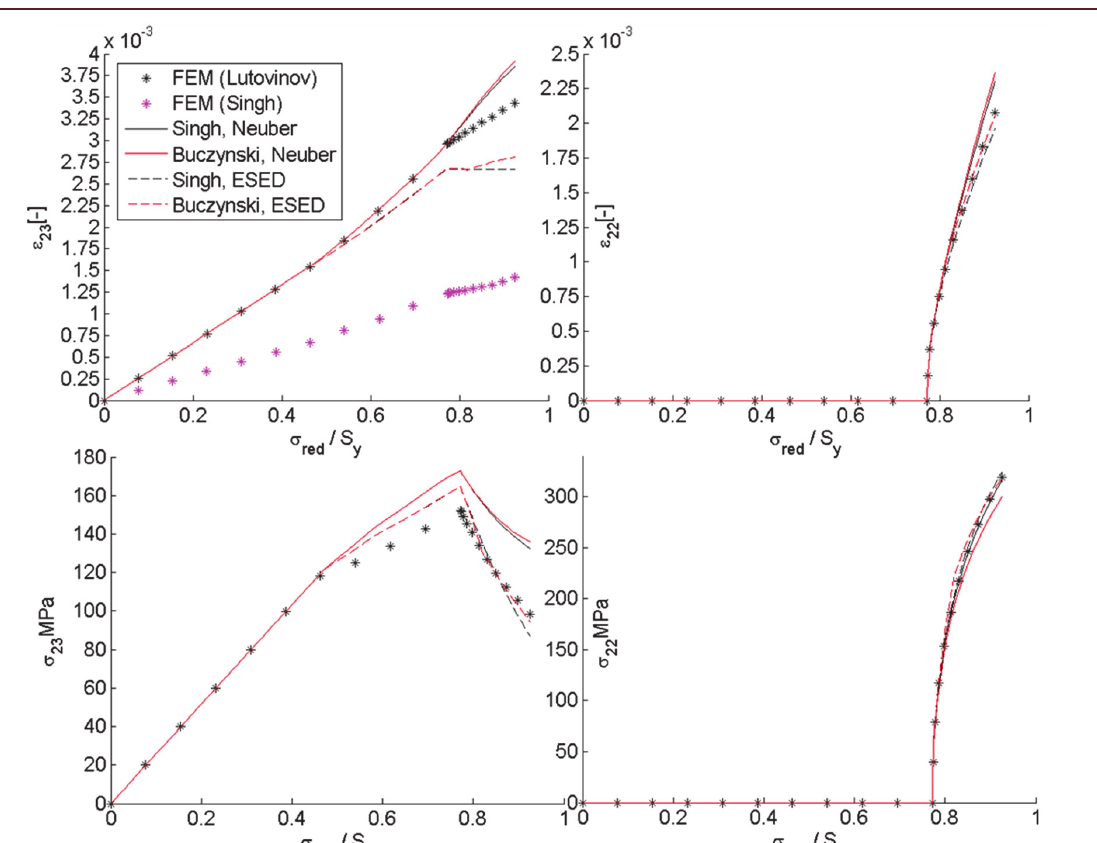
Figure 2: Results of estimations carried out on the bar specimen loaded non-proportionally with subsequent tension and torsion [6]. Estimations were performed with the use of 6-linear approximation of cyclic stress–strain